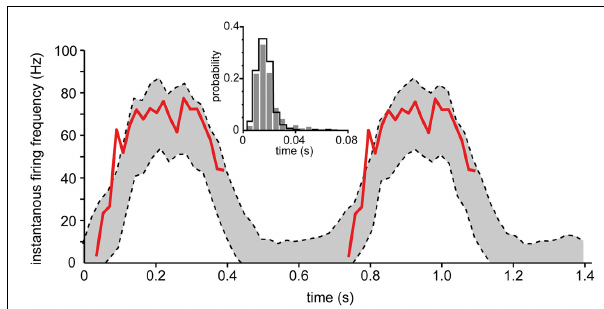
FIGURE 10 | Comparison of actual spike firing and spike firing predicted by the inhomogeneous model during fictive locomotion in spinal neurons. The model took the intracellular membrane potential modulation of dorsal spinocerebellar tract (DSCT) neurons (Figure 3 of Fedirchuk et al., 2013) as the driving input and predicted the spike firing or the neuron using the inhomogenous model fitted to one of our spinal interneurons. The 95% confidence bounds predicted by the model (dashed lines) is shown and compared to the actual instantaneous firing frequency (red line) (Fedirchuk et al., 2013). Just like the experimental data, the two step cycles in the figure was binned into 30 bins each, where the data to each bin was computed from 12 simulations. This procedure was repeated 250 times to calculate the confidence bounds of each bin. (inset) Histogram showing the probability distribution of the ISIs from Fedirchuk et al. (2013) (solid curve), compared to those obtained through simulation (gray